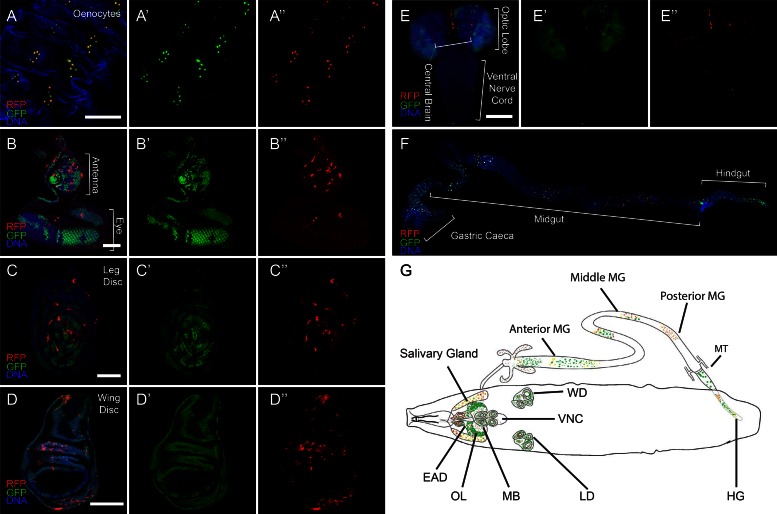
CasExpress activation in larval tissues.(A–F) Confocal micrographs showing overlays of DAPI, RFP and GFP expression in the indicated tissues of wandering 3rd instar larvae. (A’–E’) GFP only. (A”–E”) RFP only. The brackets in D mark the eye and antenna parts of the disc, in E mark the position of optic lobe, central brain and ventral nerve cord, and in F mark the different regions of the gut. Scale bars in A and F are 200 μm, in B and C are 50 μm, in D and E are 100 μm. (G) A schematic summarizing of GFP and RFP expression in larvae. There is little GFP/RFP expression in trachea or muscles, which are not included in diagram.